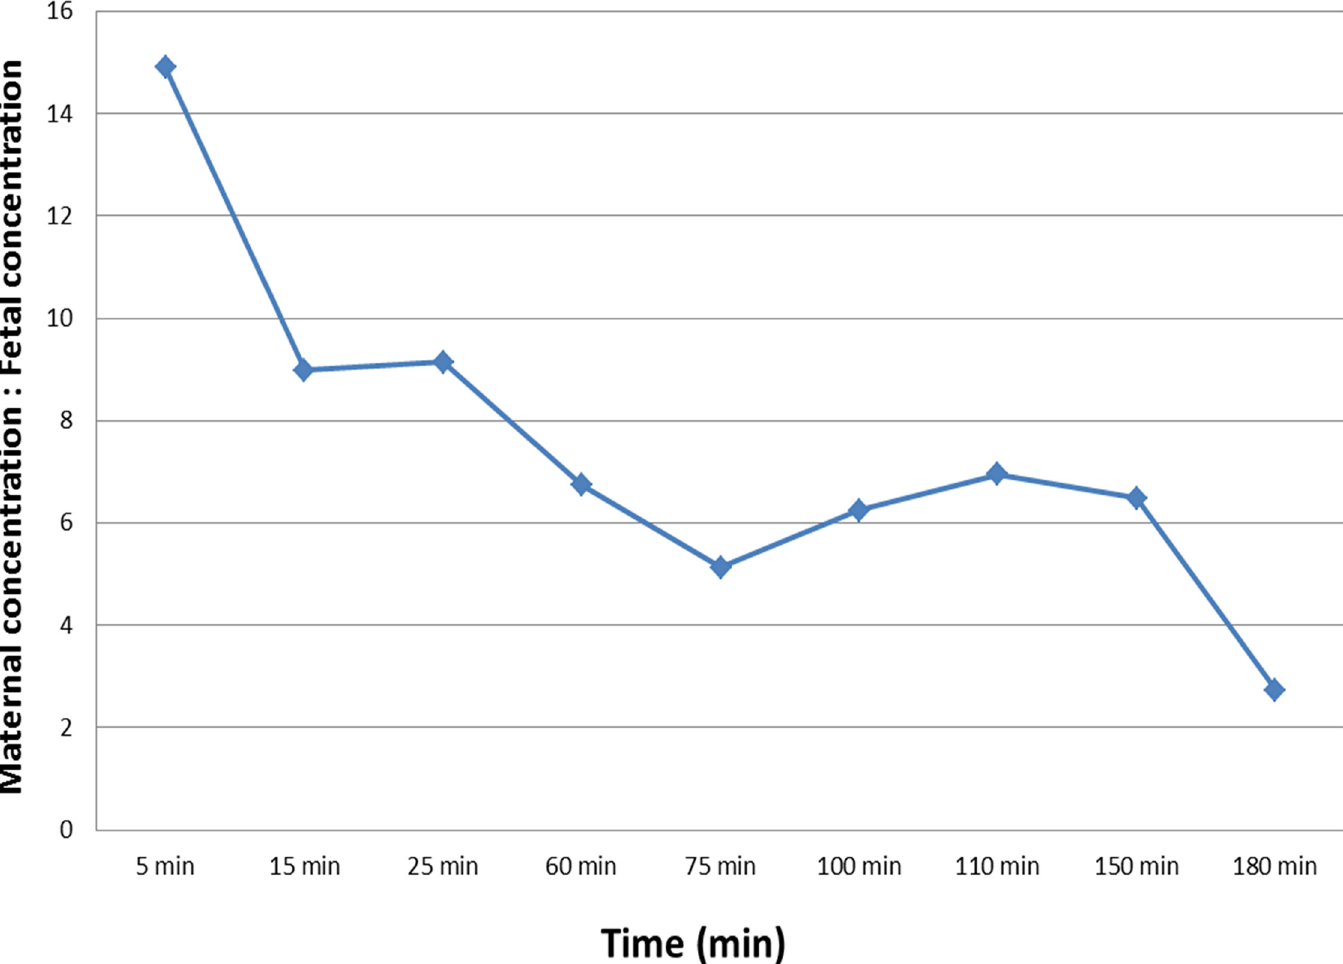
Fig 2. The mean difference between maternal and fetal propofol plasma concentration in sheep after a bolus of propofol 3 mg/kg via the maternal femoral venous line, followed by an intravenous infusion of propofol (450 mcg/kg/min) for 60 minutes and then propofol infusion (75 mcg/kg/min) for 90 more